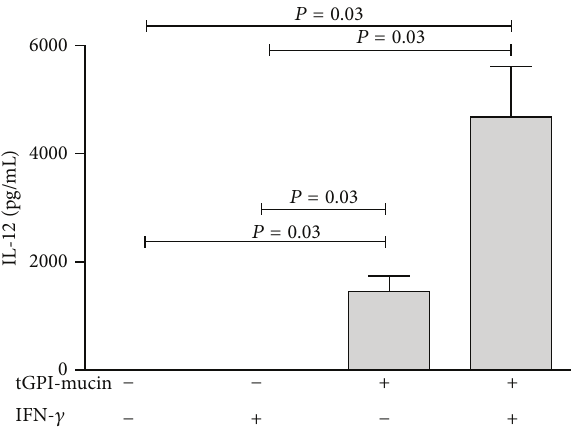
Figure 3: tGPI-mucins from T. cruzi induce IL-12 production by human monocytes. Results come from 3 distinct experiments. Groups were compared by a nonparametrical test (Mann-Whitney Rank Sum Test) with GraphPad InStat software (version 5.0; Graph- Pad). Results were expressed as medians and interquartile ranges. 𝑃 values were considered significant if <